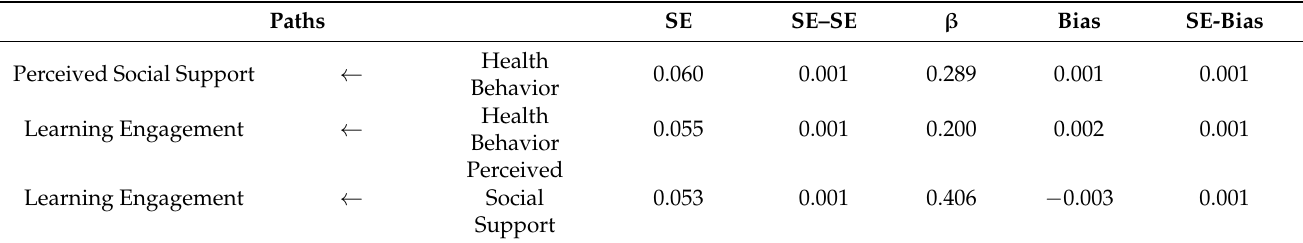
Table 8. Table of standardized estimates and their standard errors reported.